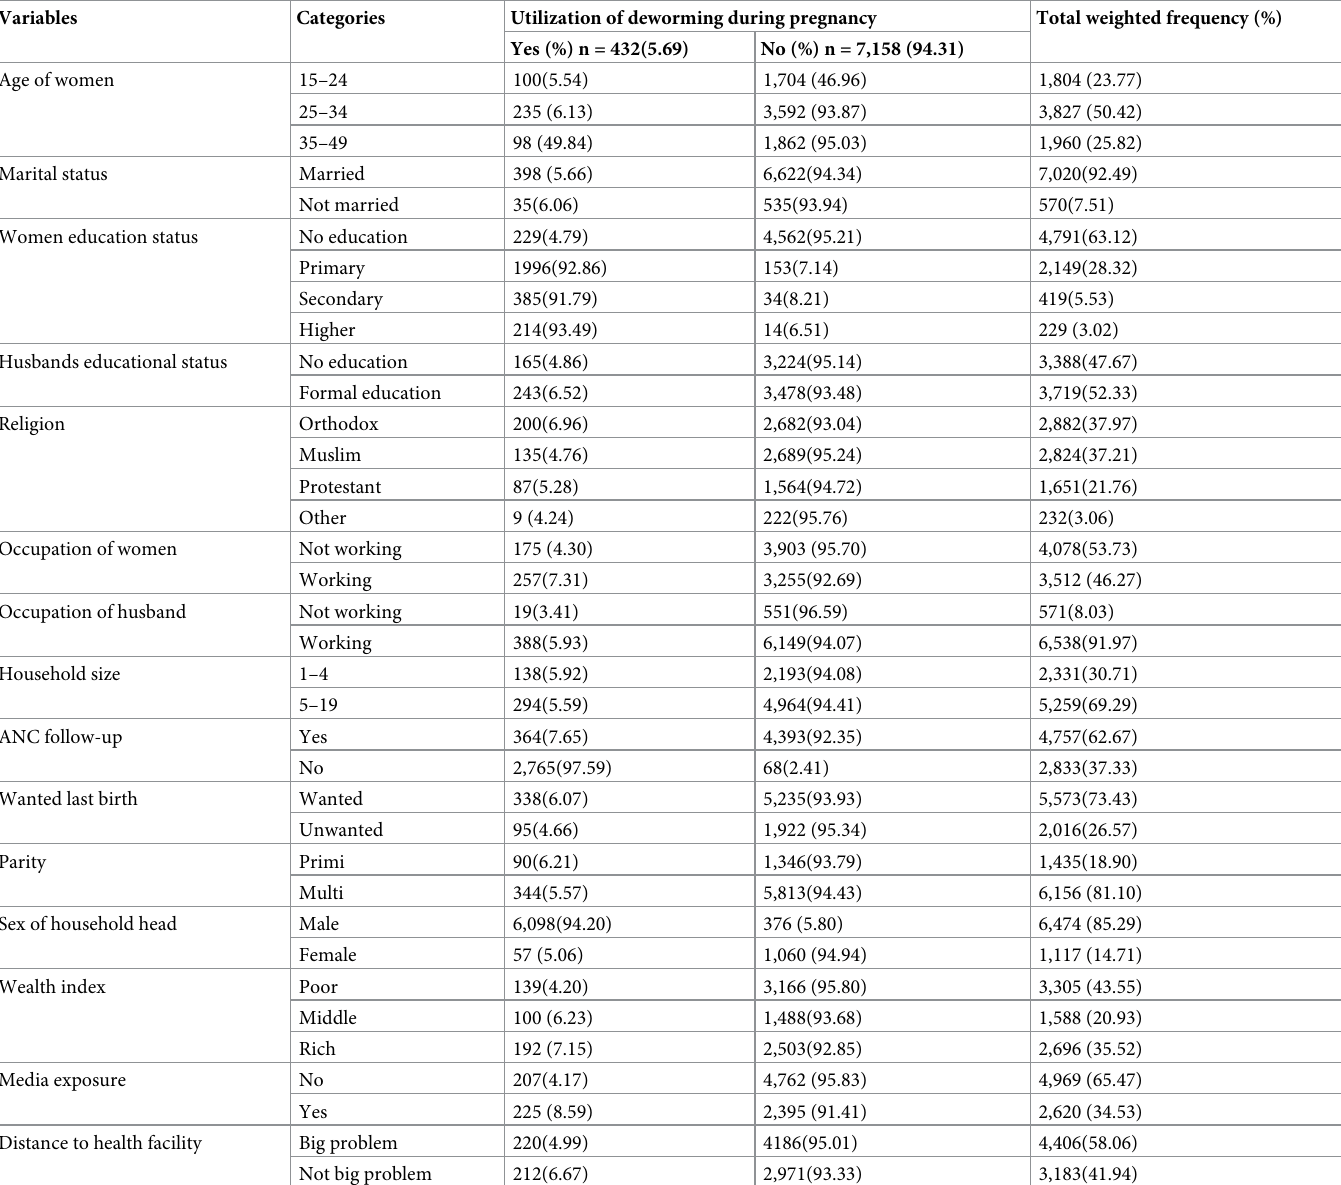
Table 1. Sociodemographic and economic characteristics for utilization of deworming among pregnant women, 2016